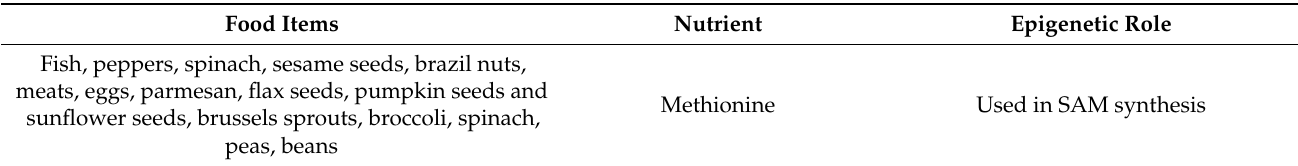
Table 3. Dietary components and their epigenetic role c